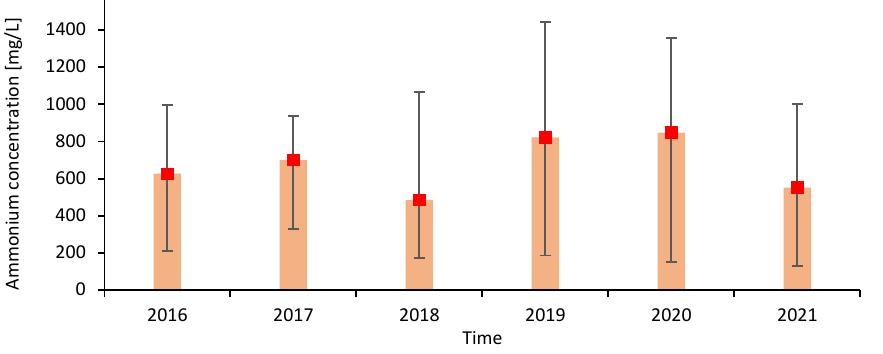
Figure 8. The average monthly ammonium nitrogen concentration in the ZUOK industrial wastewater between December 2015 and December 2021.